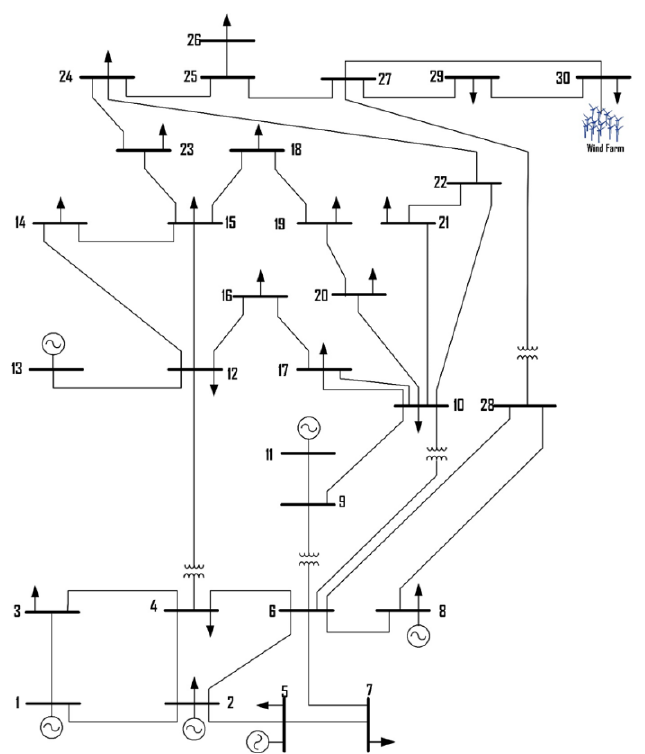
Figure 8. The IEEE-30 node standard test feeder with WPP at node ‘30’ [56].